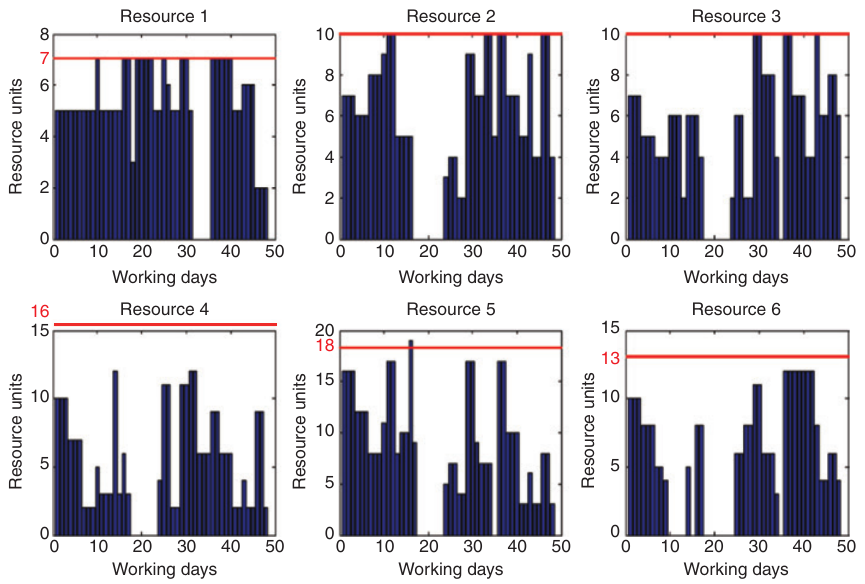
Figure 11: Resource Utilization with